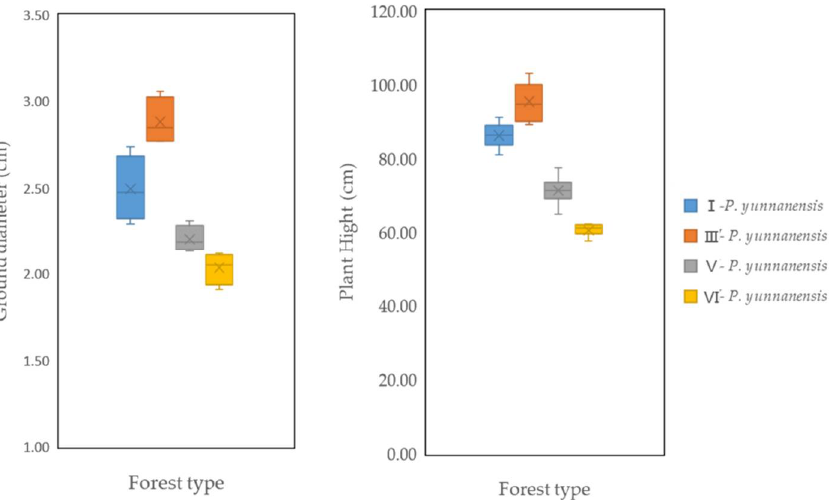
Figure 4. The growth status of P. yunnanensis of four forest types after two years of afforestation.